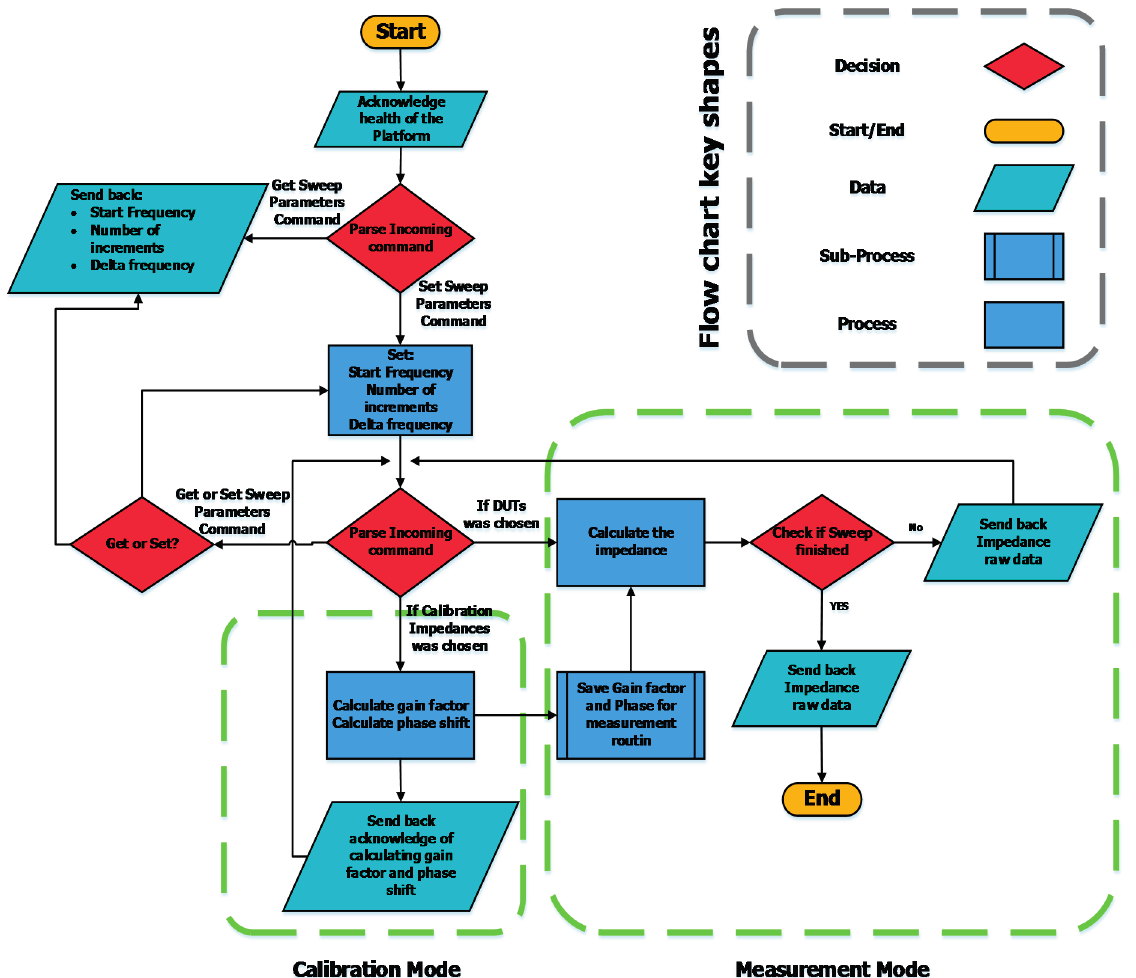
Figure 4. Flowchart of the DIS platform embedded